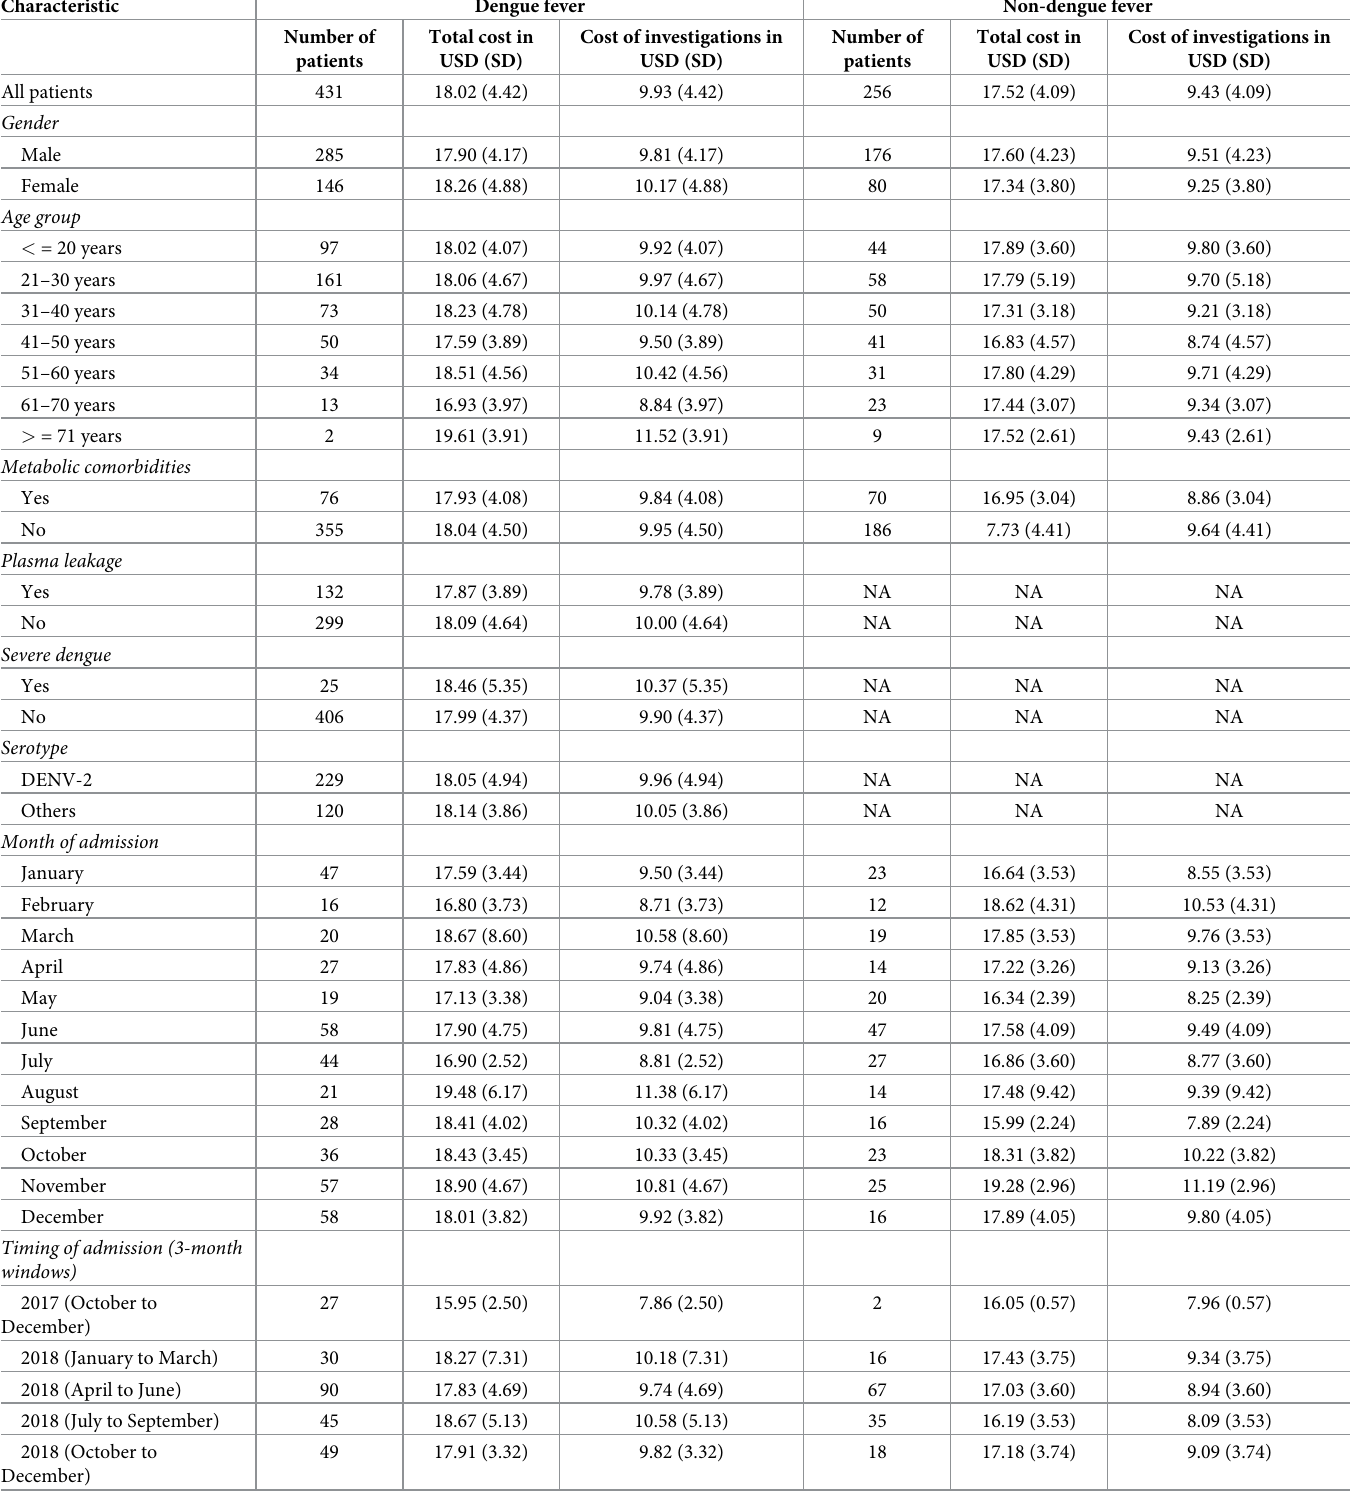
Table 1. Standardised costs (as cost per patient per day) for dengue fever (DF) and non-dengue fever (NDF) patients in Colombo Dengue Study.